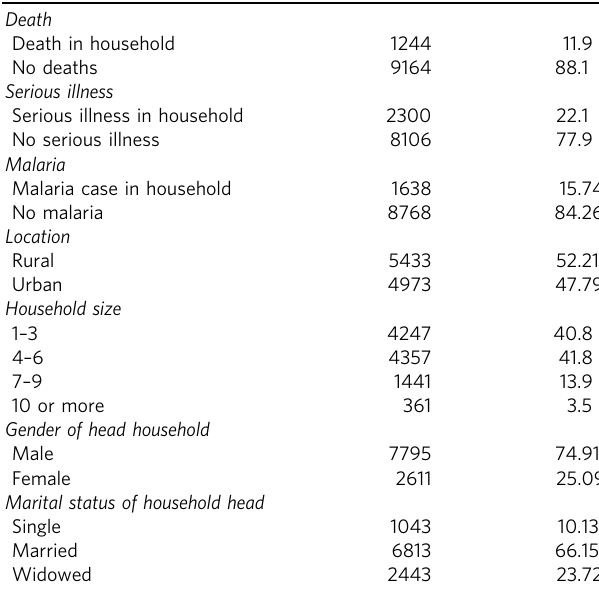
Table 2 Summary of descriptive statistics. Demographic and sanitary characteristics Number affected %